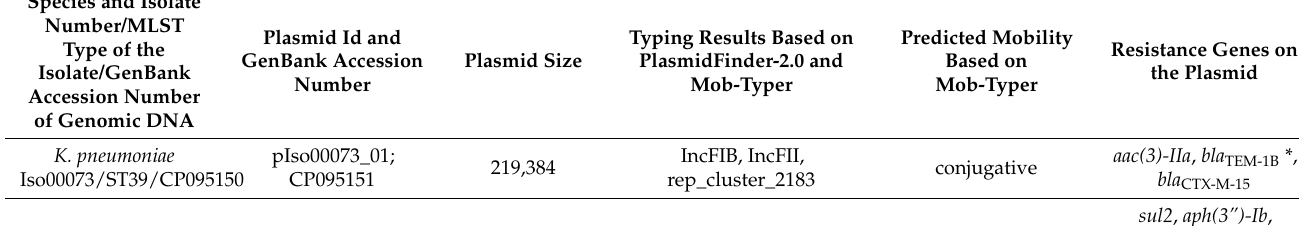
Table 1. Identified plasmids with information on size, typing results based on PlasmidFinder-2.0 and mob-typer, predicted mobility based on mob-typer and encoded resistance genes. Resistance genes occurring with more than one copy are marked with